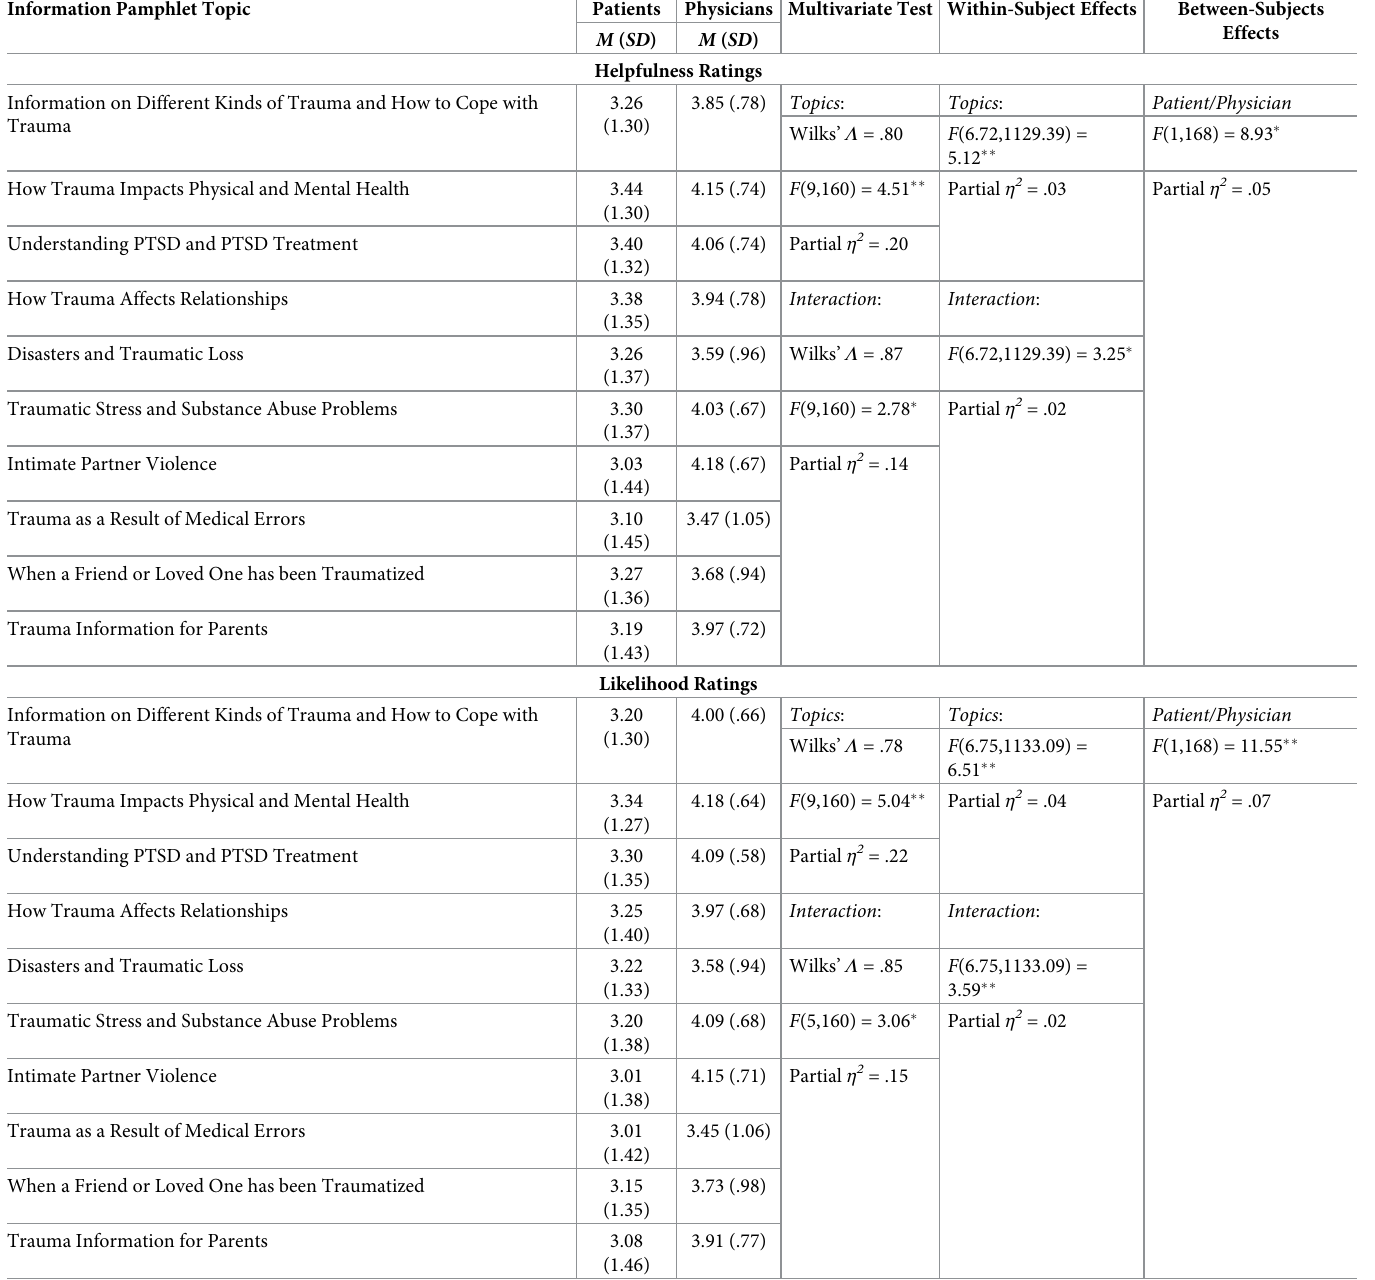
Table 5. Repeated measures ANOVA for patients’ and physicians’ opinion on information